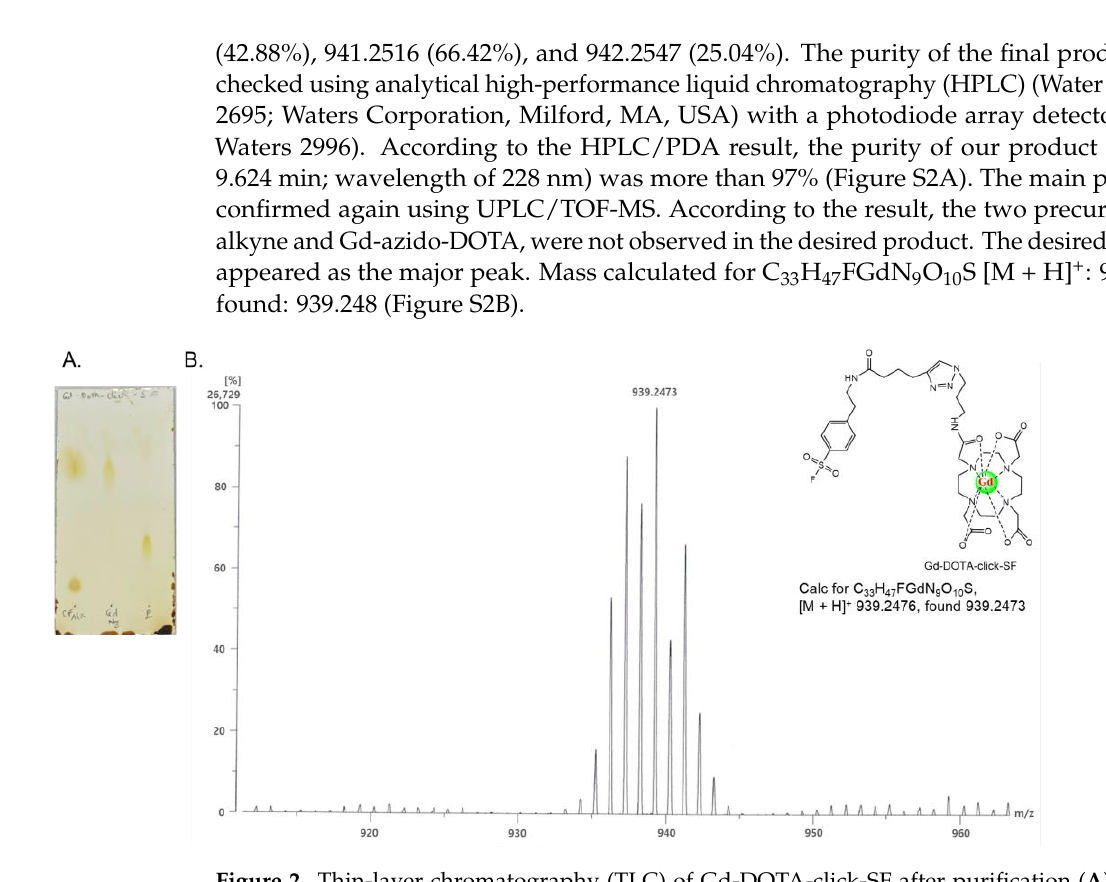
Figure 2. Thin-layer chromatography (TLC) of Gd-DOTA-click-SF after purification ( A ) (SF-Alk, SF-alkyne; Gd-N 3 , Gd-azido-DOTA; P, product (Gd-DOTA-click-SF after purification)). HR-FAB mass spectrum of Gd- DOTA-click-SF ( B ).